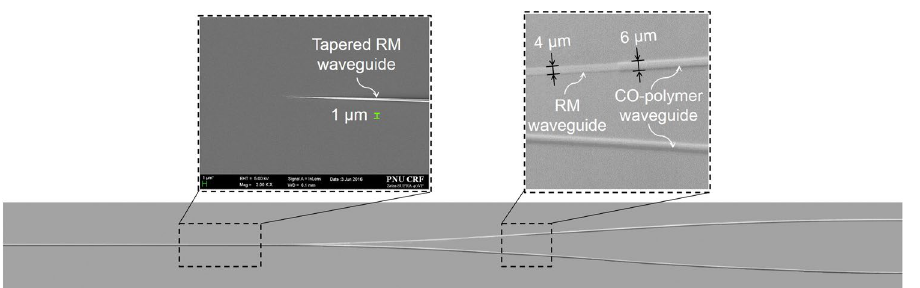
Figure 7. Microphotograph of the polarization splitting Y-branch waveguide, and SEM image of the tapered RM waveguide where the width is gradually decreasing to much less than 1 μ